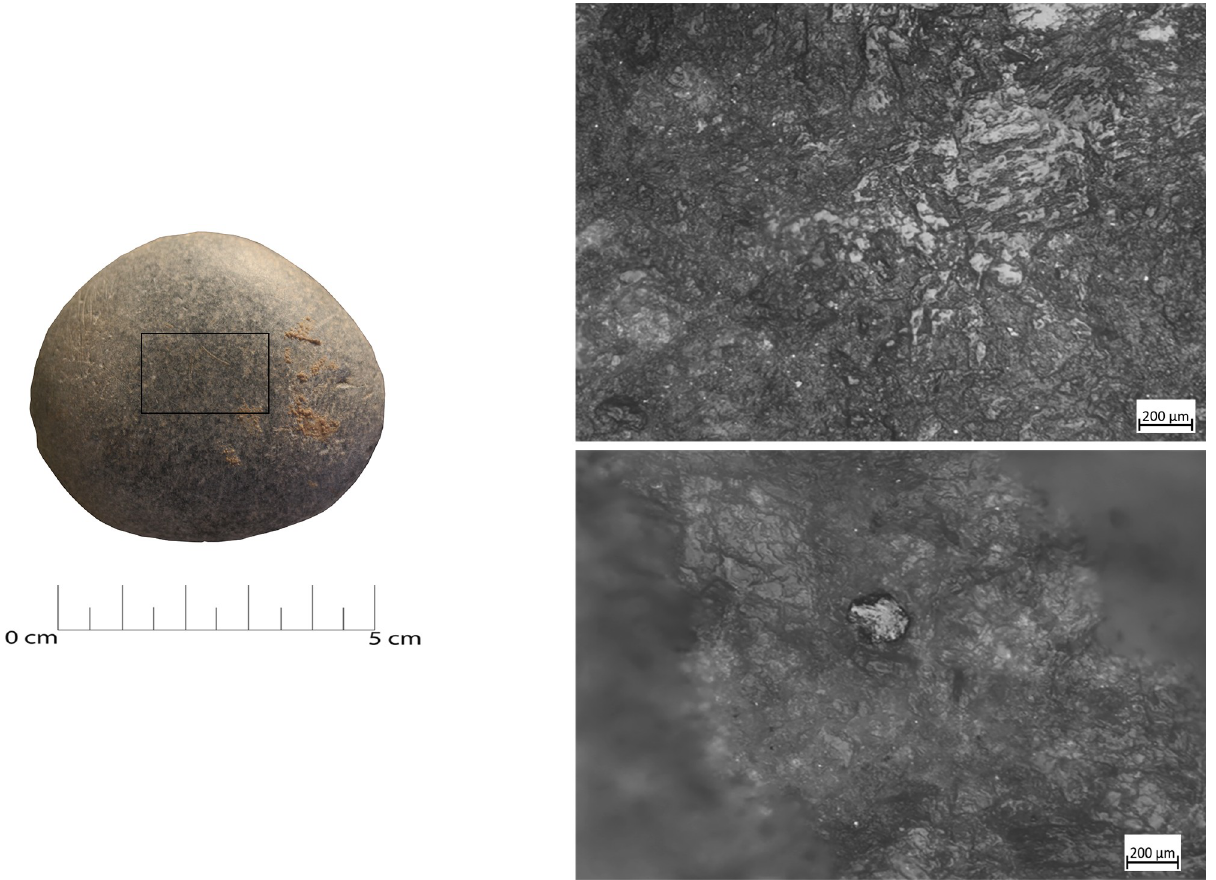
Fig 21. RF127b archaeological sample with intense rounding of the grains over the central area of the flat surface. (a) Polishing (100x) affecting the top of the grains; (b) patch of polish characterised by a flat topography and smooth texture (200x).